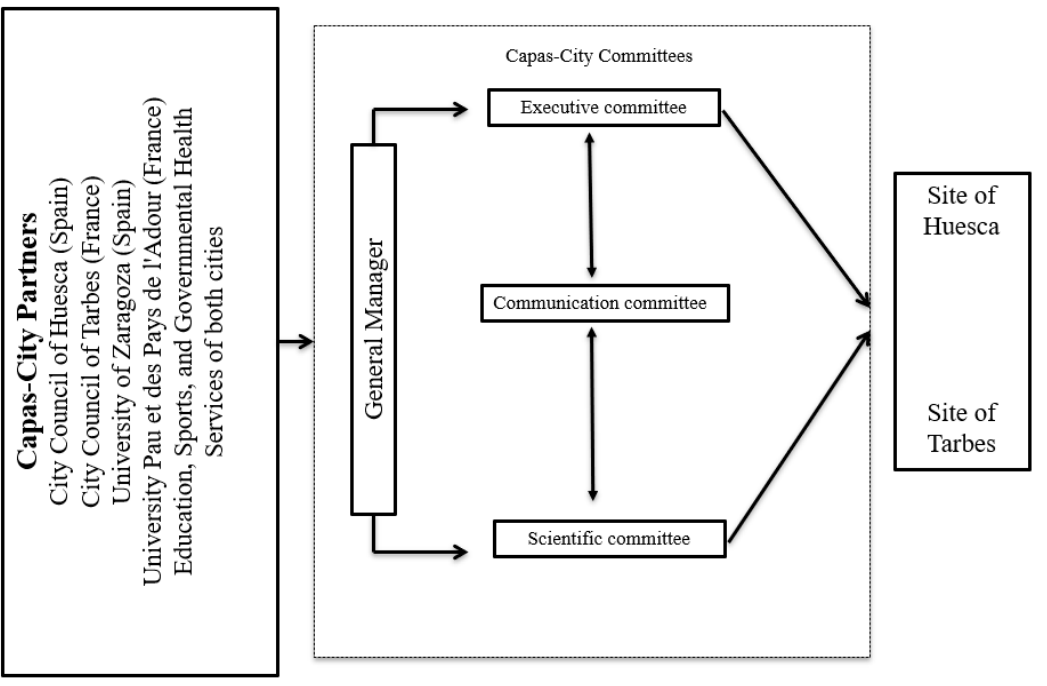
Figure 1. Organizational structure of CAPAS-City.